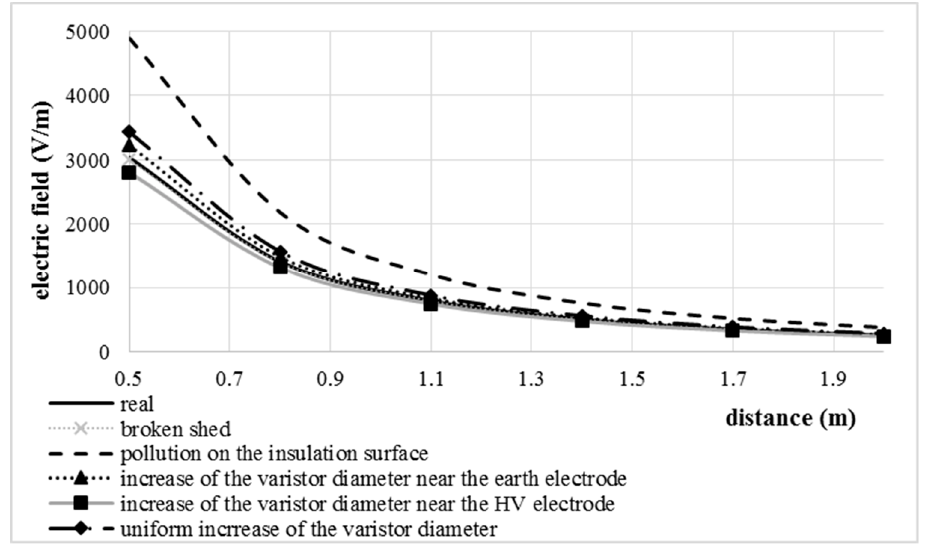
Figure 15. Electric field (V/m) in function with the distance from the arrester (height from the earth electrode equal to 13 cm).